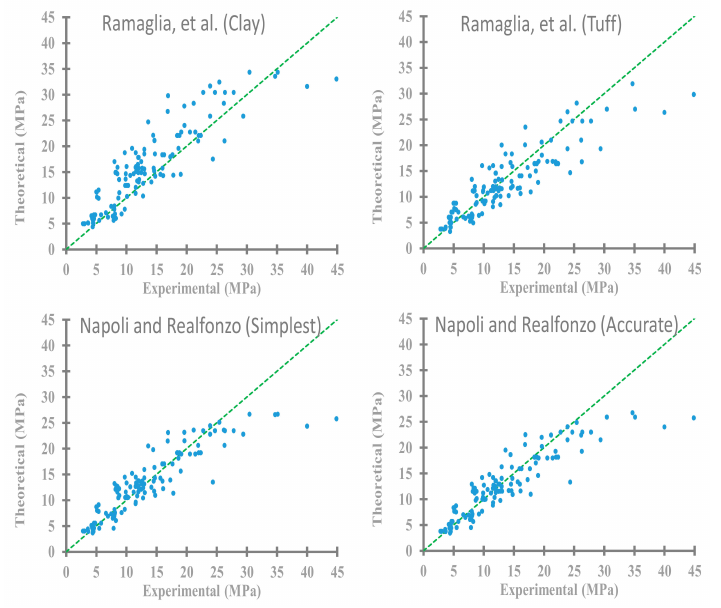
Figure 12. Theoretical and experimental behavior of existing models